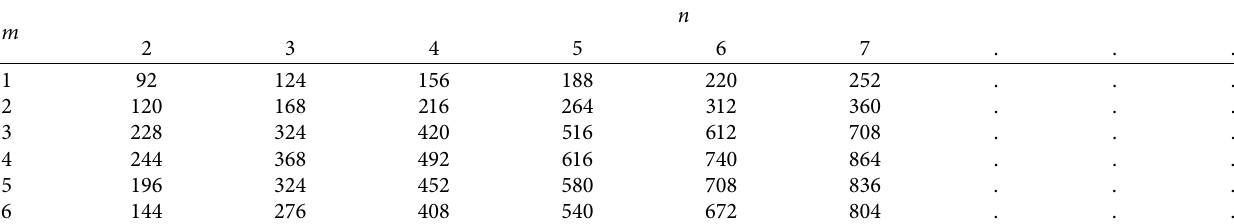
Table 3: Number of pair of vertices in HHC-2 at different distances.